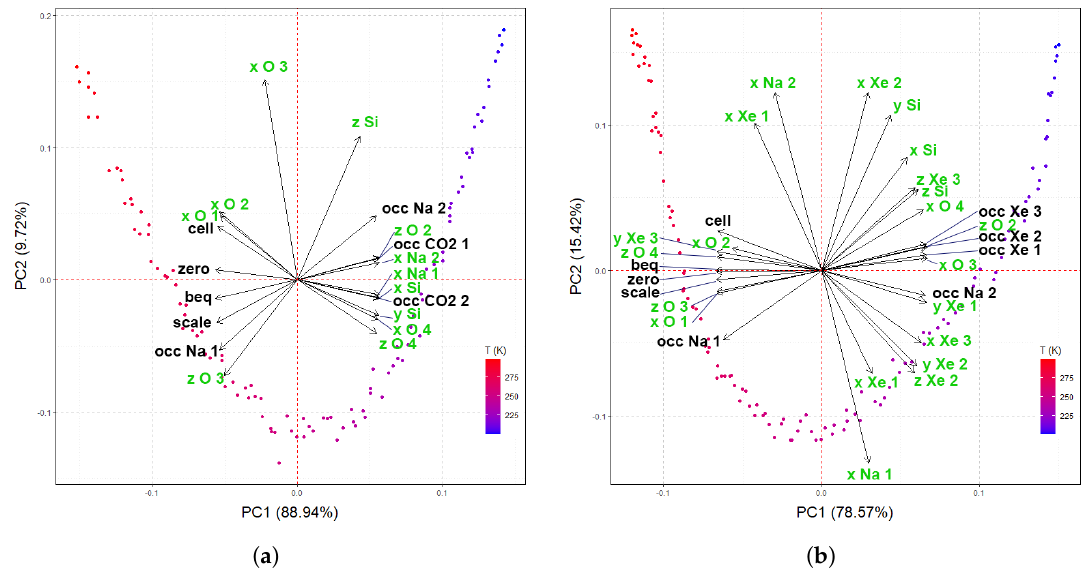
Figure 8. Biplots obtained by PCA of parameters refined by Rietveld for Xe and CO 2 adsorption. Biplot of ( a ) CO 2 and ( b ) Xe data.